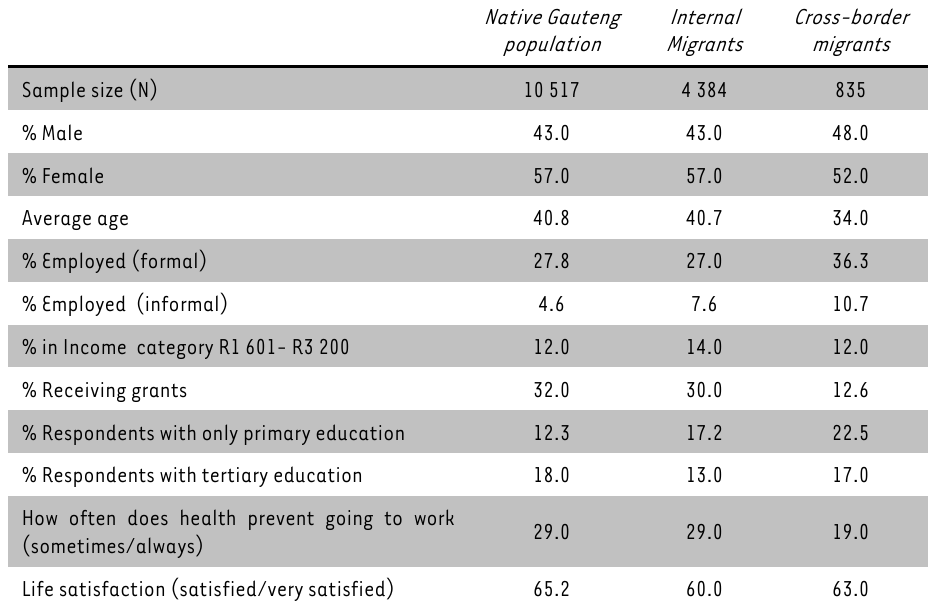
Descriptive statistics of the different analysed groups